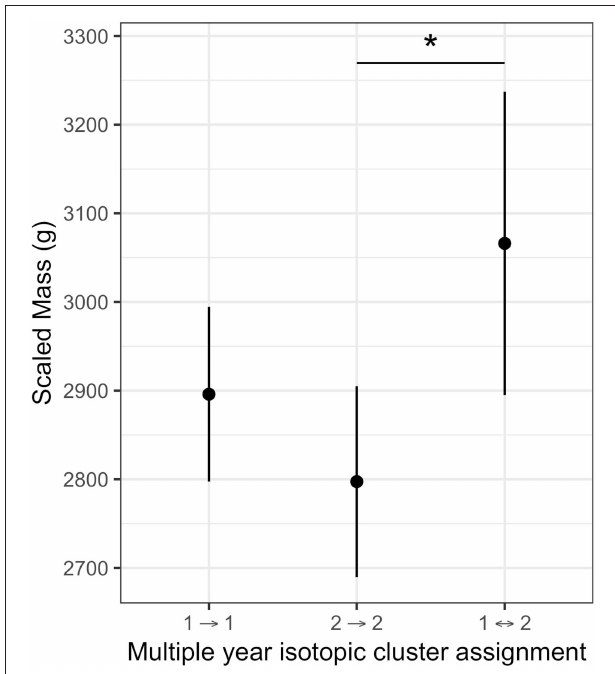
FIGURE 5 | Partial effect of dietary strategy on scaled mass (g) for northern gannets sampled in two consecutive years at Bass Rock and Grassholm ( n = 34) after accounting for effect of Colony and Sex. Individuals were assigned to isotopic clusters in each year based on a multivariate normal mixture model of primary feather δ 13 C and δ 15 N. Individuals ( n = 5) that switched between cluster one and cluster two were heavier relative to those individuals that remained within either cluster one ( n = 15) or cluster two ( n = 14). Post-hoc comparisons (*) P <